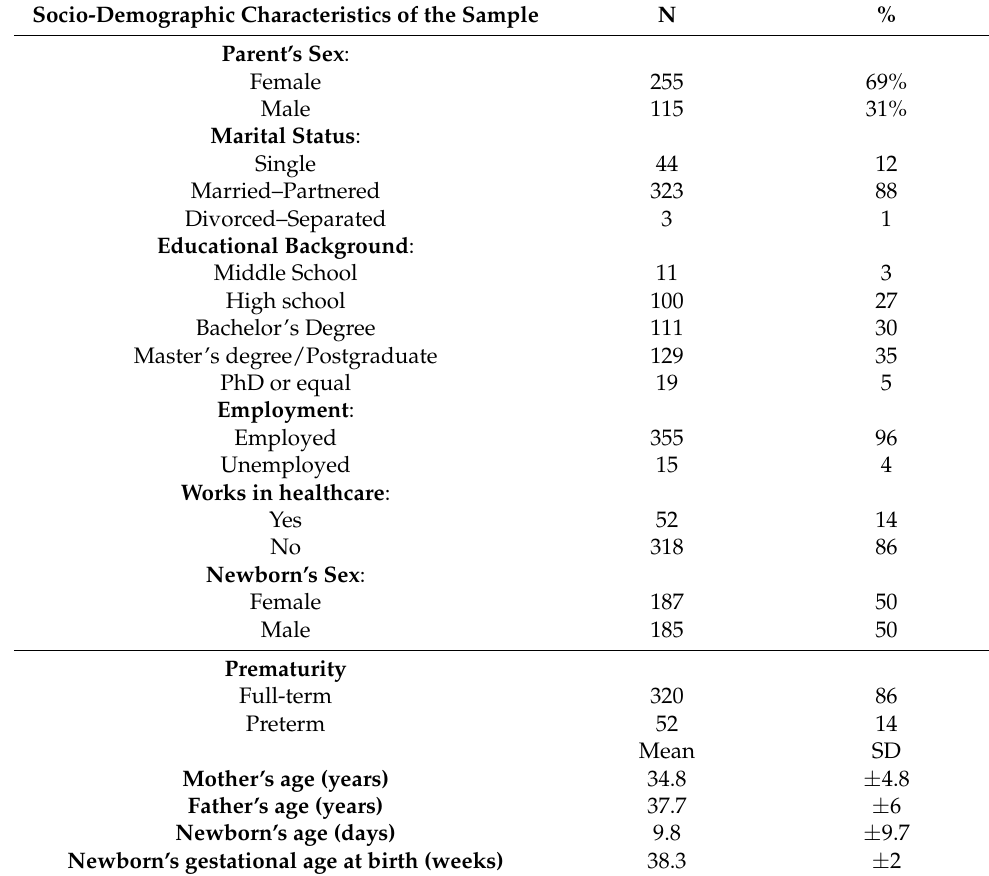
Table 1. Population’s characteristics. Variables are expressed as number of observations (%) or as mean ± standard deviation (SD). Socio-Demographic Characteristics of the